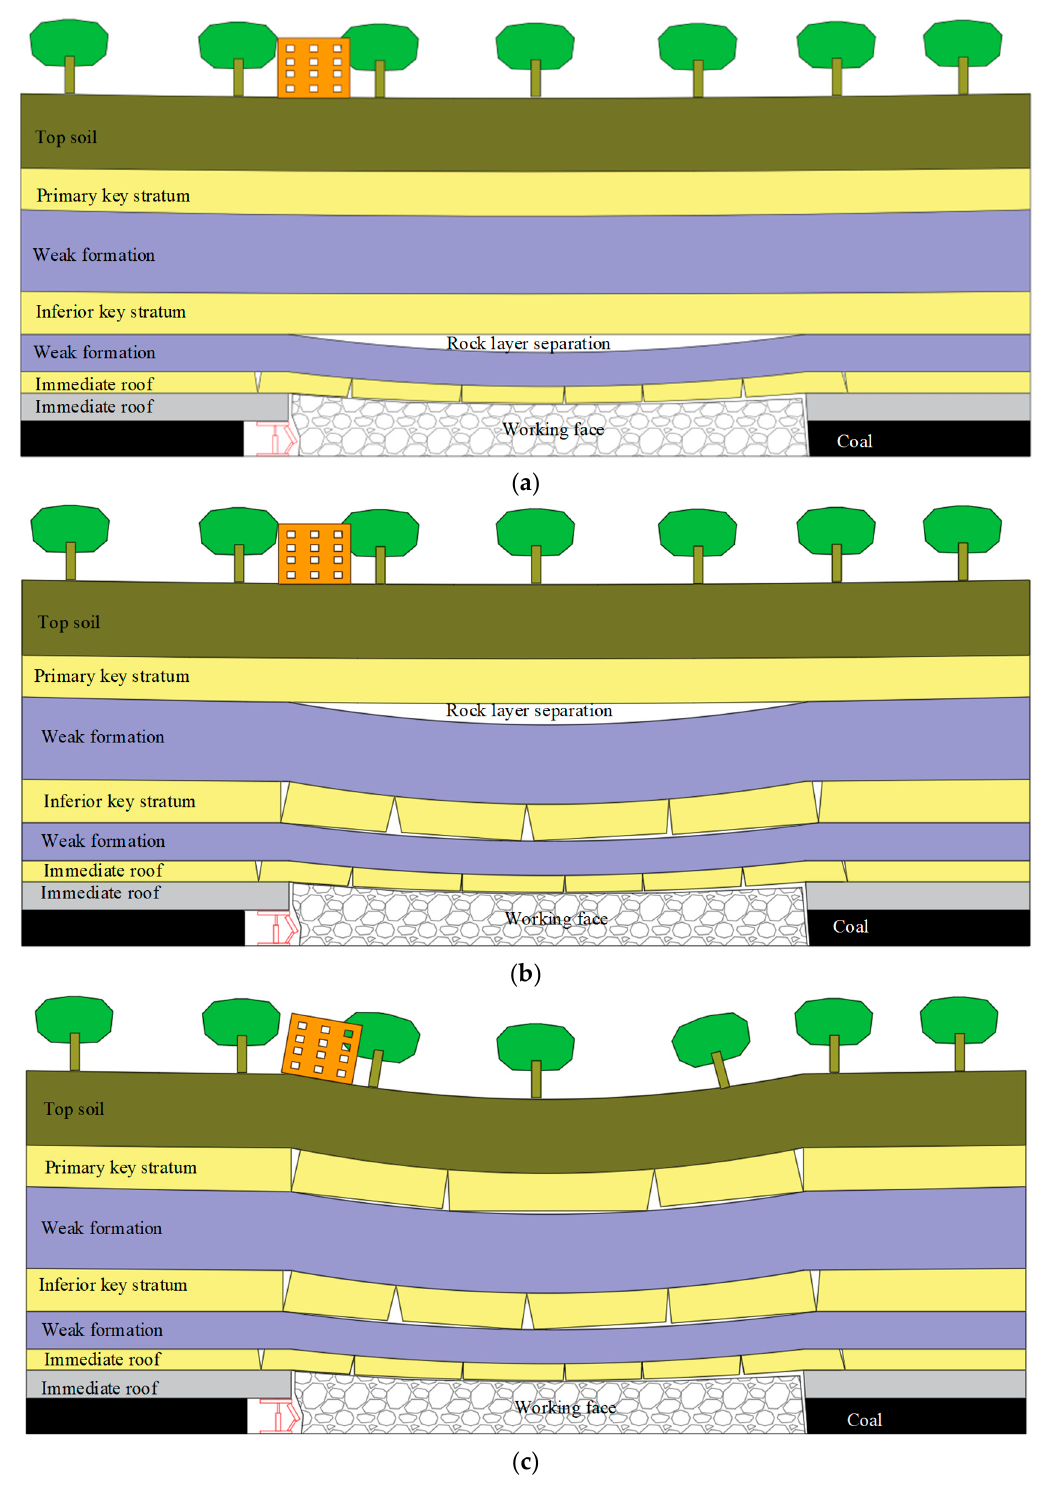
Figure 1. Breaking Structure of Overburden Rock Migration in Stope Roof. ( a ) Immediate roof break- age; ( b ) Inferior key stratum breakage; ( c ) Primary key stratum breakage.